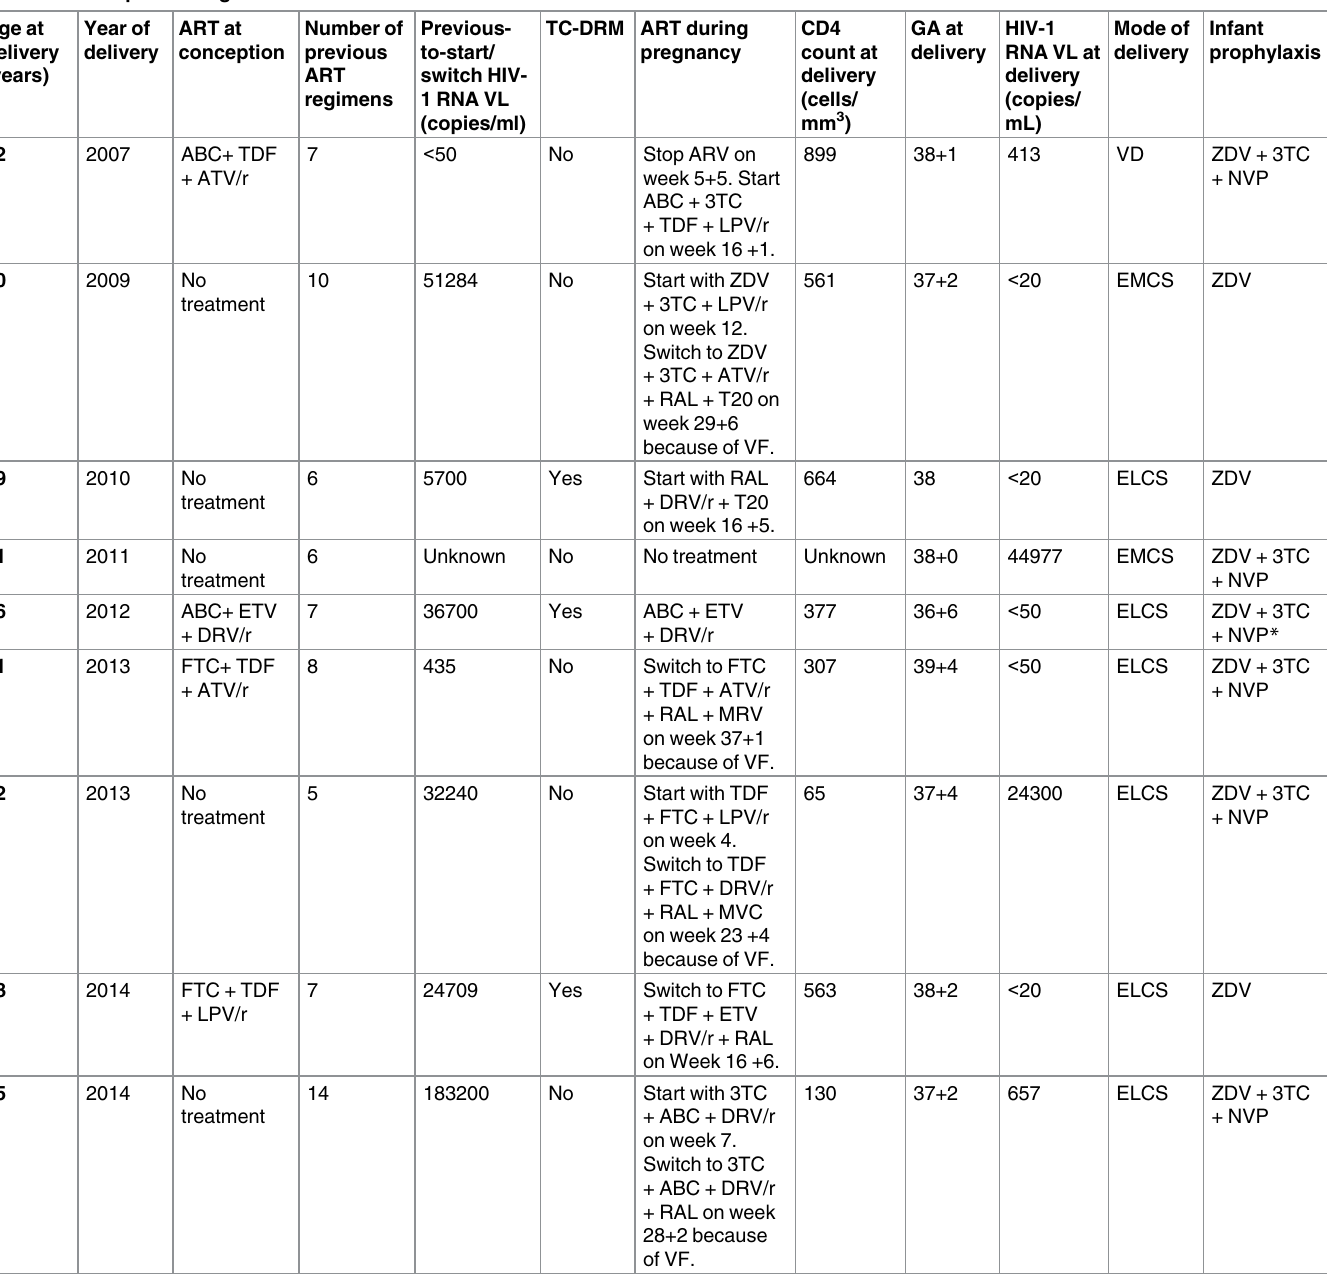
Table 3. Description of high risk casesfor HIV mother-to-child